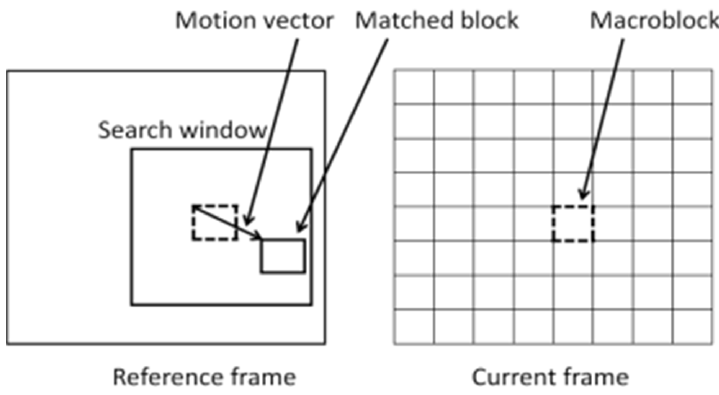
Figure 1. The basic idea of motion estimation.